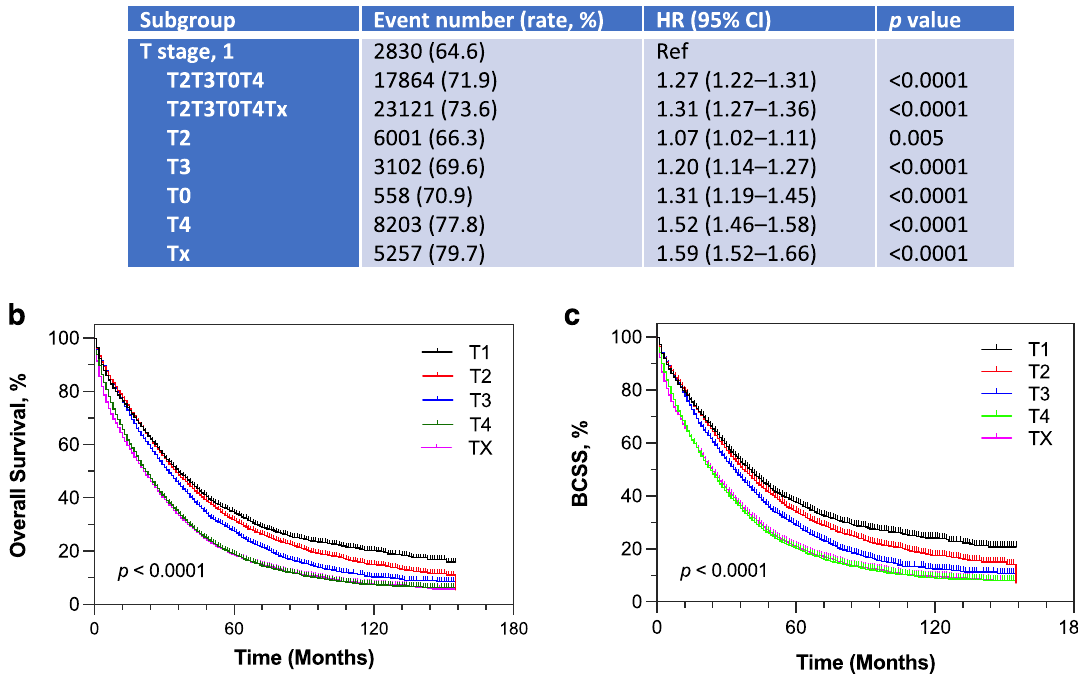
Fig. 3 Event rate and all-cause mortality by T stage, and OS and BCSS by T stage in patients with metastatic breast cancer. a Event rate and risk of mortality by T stage at univariate level. HR and 95% CI of ratio were computed by Cochran – Mantel – Haenszel test. HR, hazard ratio; Ref, reference population. Kaplan – Meier estimate b , for OS and c , for BCSS strati fi ed by T1, T2, T3, T4 and Tx. Tick-marks represented the censored patients at the time of last known alive. BCSS, breast cancer-speci fi c survival; OS, overall